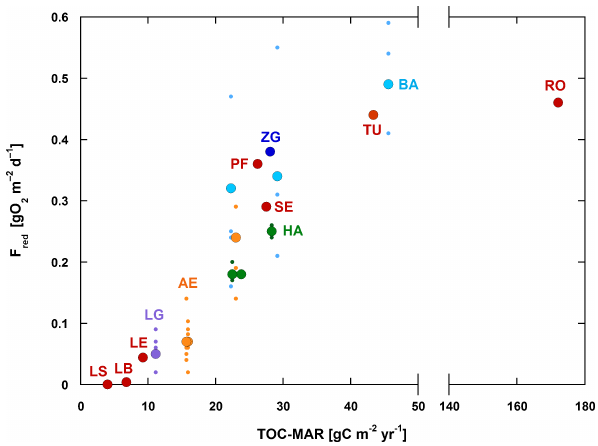
Figure 2. F red of 11 different lakes plotted against the total or- ganic carbon mass accumulation rate (TOC-MAR). Values for lakes Baldegg (BA), Hallwil (HA), and Aegeri (AE) were averaged from up to five measurements (big circles); those for Lake Zug (ZG) were calculated from a single core at 62m water depth. Small circles show each individual F red result at the respective sampling loca- tion. The variations of F red in Lake Geneva show only the varia- tions due to sampling depths as all cores were collected in summer. Red marks were calculated from single-core literature data (Lake Baikal (LB): Och et al., 2012; Lake Sempach (SE): Müller et al., 2012b; Rotsee (RO): Naeher et al., 2012; Pfäffikersee (PF, unpub- lished); and Türlersee (TU, unpublished)). TOC-MAR values from Lake Geneva (LG) are based on sedimentation rate estimates from the literature (Vernet et al., 1983; Loizeau et al., 2012; Span et al., 1990). TOC-MAR and F red values from Lake Erie (LE) were ex- tracted from Matisoff et al. (1977), Adams et al. (1982), and Smith and Matisoff (2008). Values for Lake Superior (LS) were compiled from Klump et al. (1989), Remsen et al. (1989), Richardson and Nealson (1989), Heinen and McManus (2004), and Li et al.